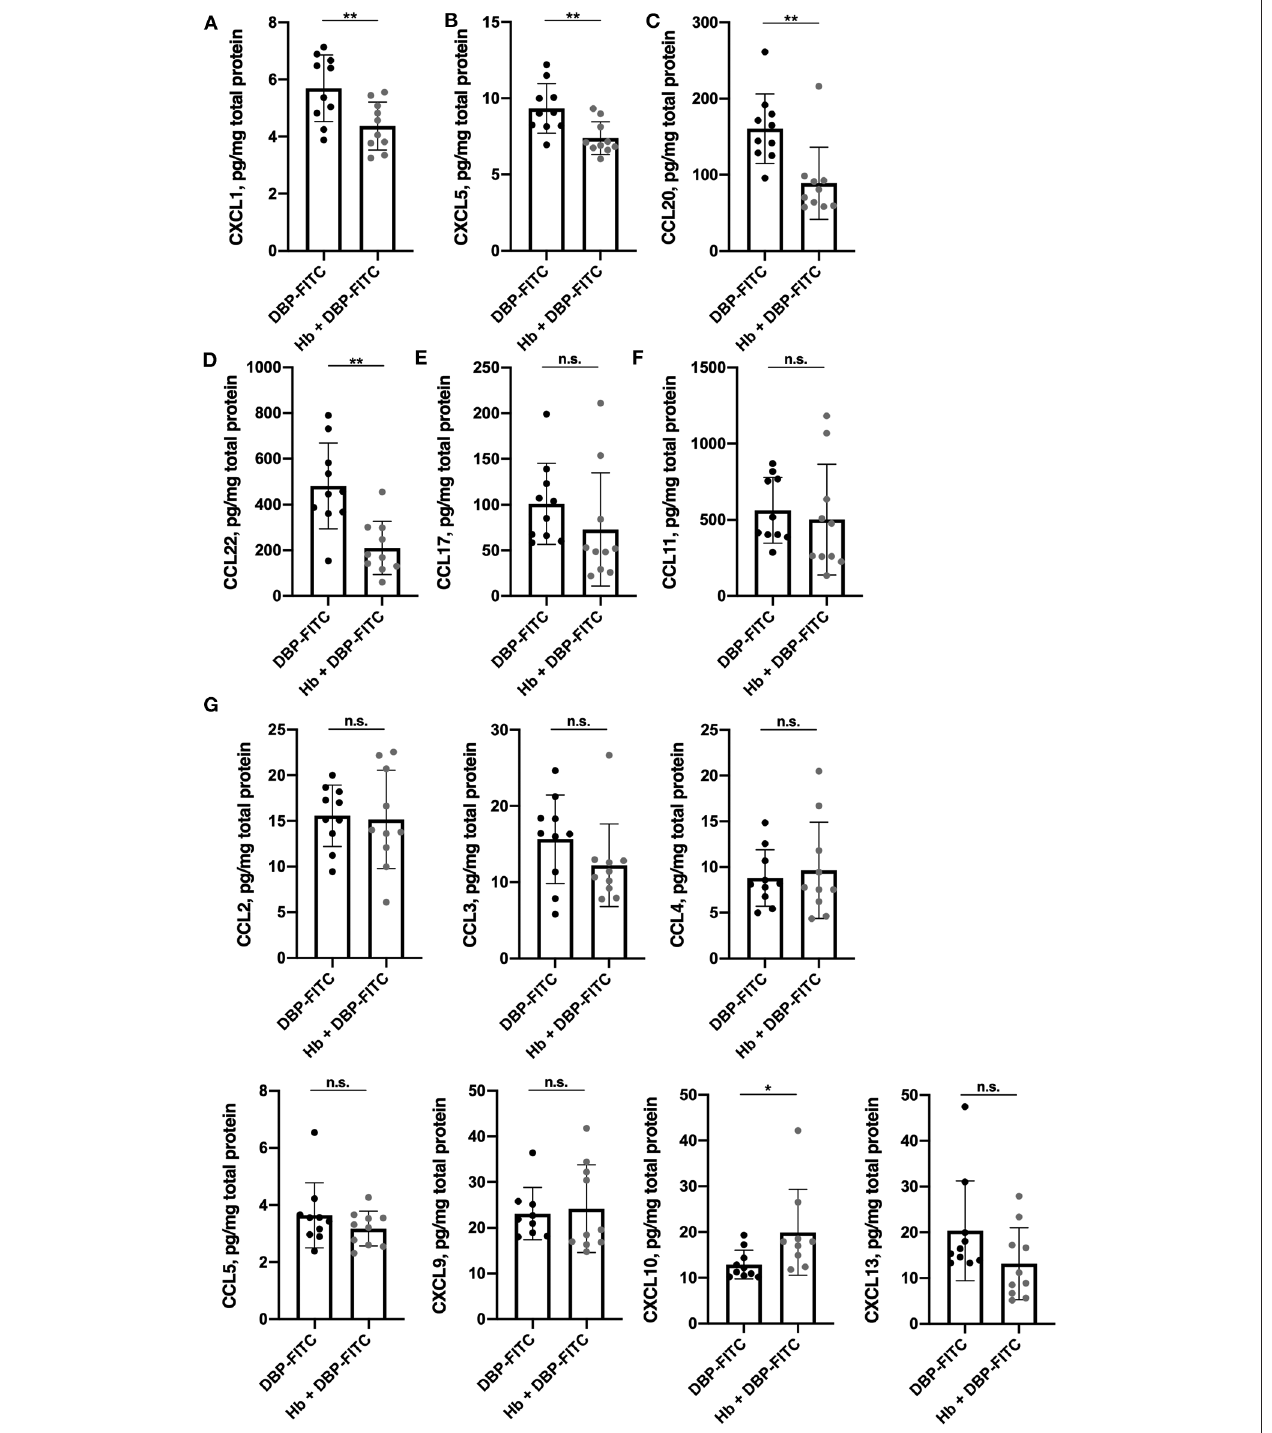
FIGURE 4 | Expression of a subset of skin-derived inflammatory chemokines is reduced in H. bakeri -infected mice after DBP-FITC sensitization. Chemokine protein expression in tissue lysate measured by LEGENDplex 12h post- sensitization with DBP-FITC. (A) CXCL1, (B) CXCL5, (C) CCL20, (D) CCL22, (E) CCL17, (F) CCL11, (G) CCL2, 3, 4, and 5 and CXCL9, 10, and 13. Results are expressed as pg/mg total protein measured by Bradford assay. An unpaired t -test was used to assess statistical differences. Graphs represent data combined from 2 experiments and show mean ± SD. n.s., not significant, * p < 0.05, ** p < 0.01.